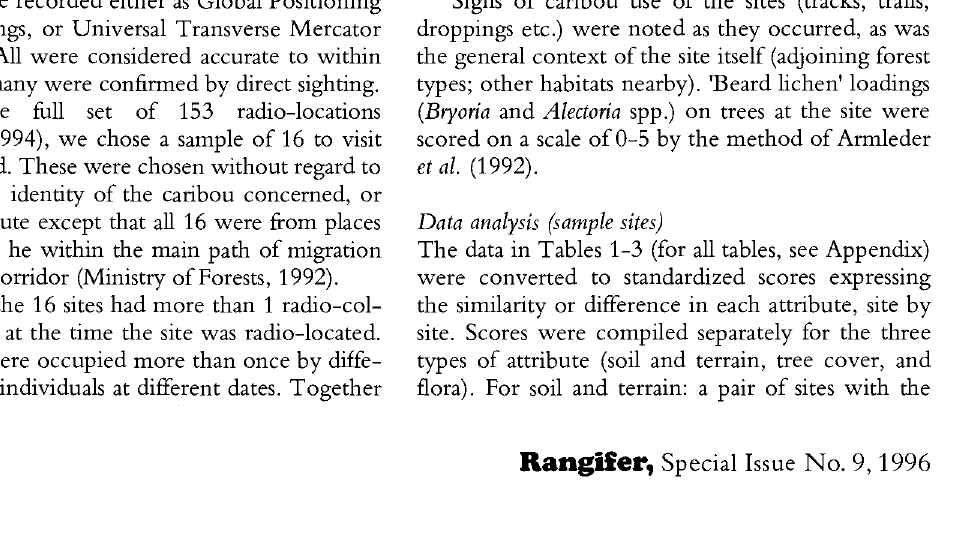
herd travelled in small groups, usually less than 10 animals per group but sometimes up to 20. R a d i